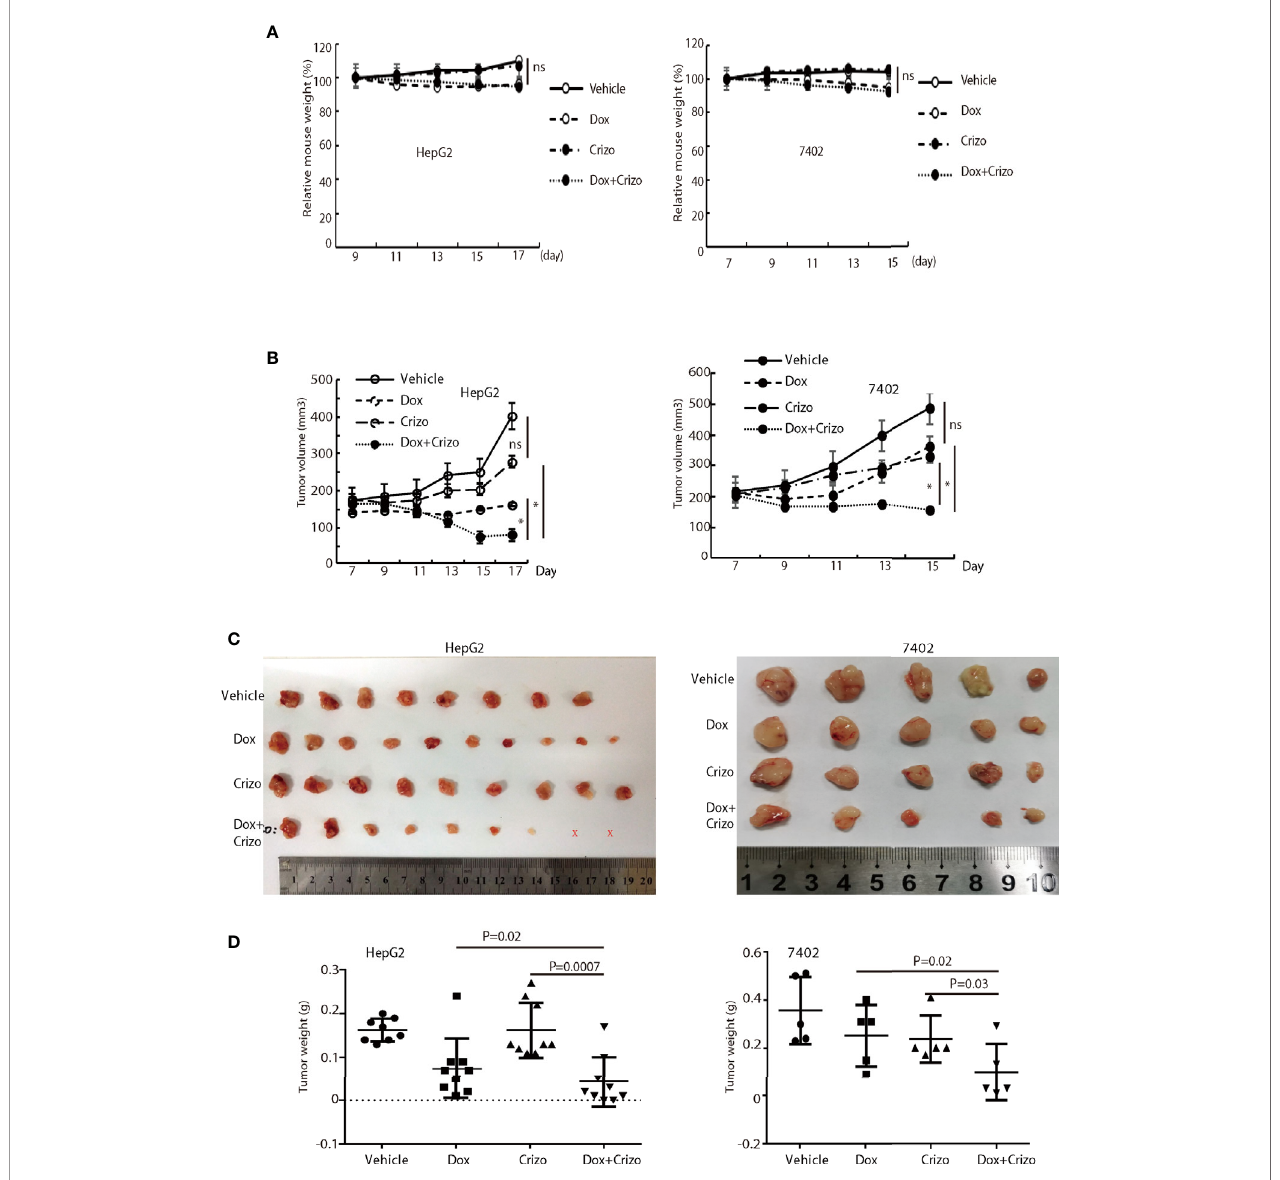
FIGURE 7 | Crizo plus Dox signi fi cantly inhibit tumor growth in vivo in xenografts. (A) Dox, or Dox plus Crizo but not Crizo slightly affected mouse weights. The weight of mouse was monitored every other day as indicated. (B) Dox plus Crizo treatment signi fi cantly reduced the xenografted tumor volume compared to Dox or Crizo treatment separately. Tumor volumes were measured starting from day 7th post xenograft as indicated. (C , D) Dox plus Crizo treatment signi fi cantly decreased the xenografted tumor weight compared to Dox or Crizo treatment separately. The dissected tumors under different treatments were placed side by side with a scale. Each dot represented the weight of a xenografted tumor. Ns, not statistically signi fi cant; *P < 0.05; or P values were indicated. X, tumors disappeared after